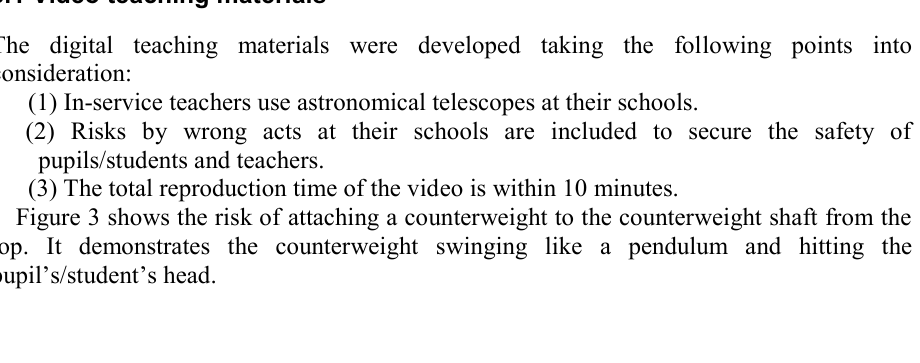
Figure 2. Thumbscrew of the counterweight shaft